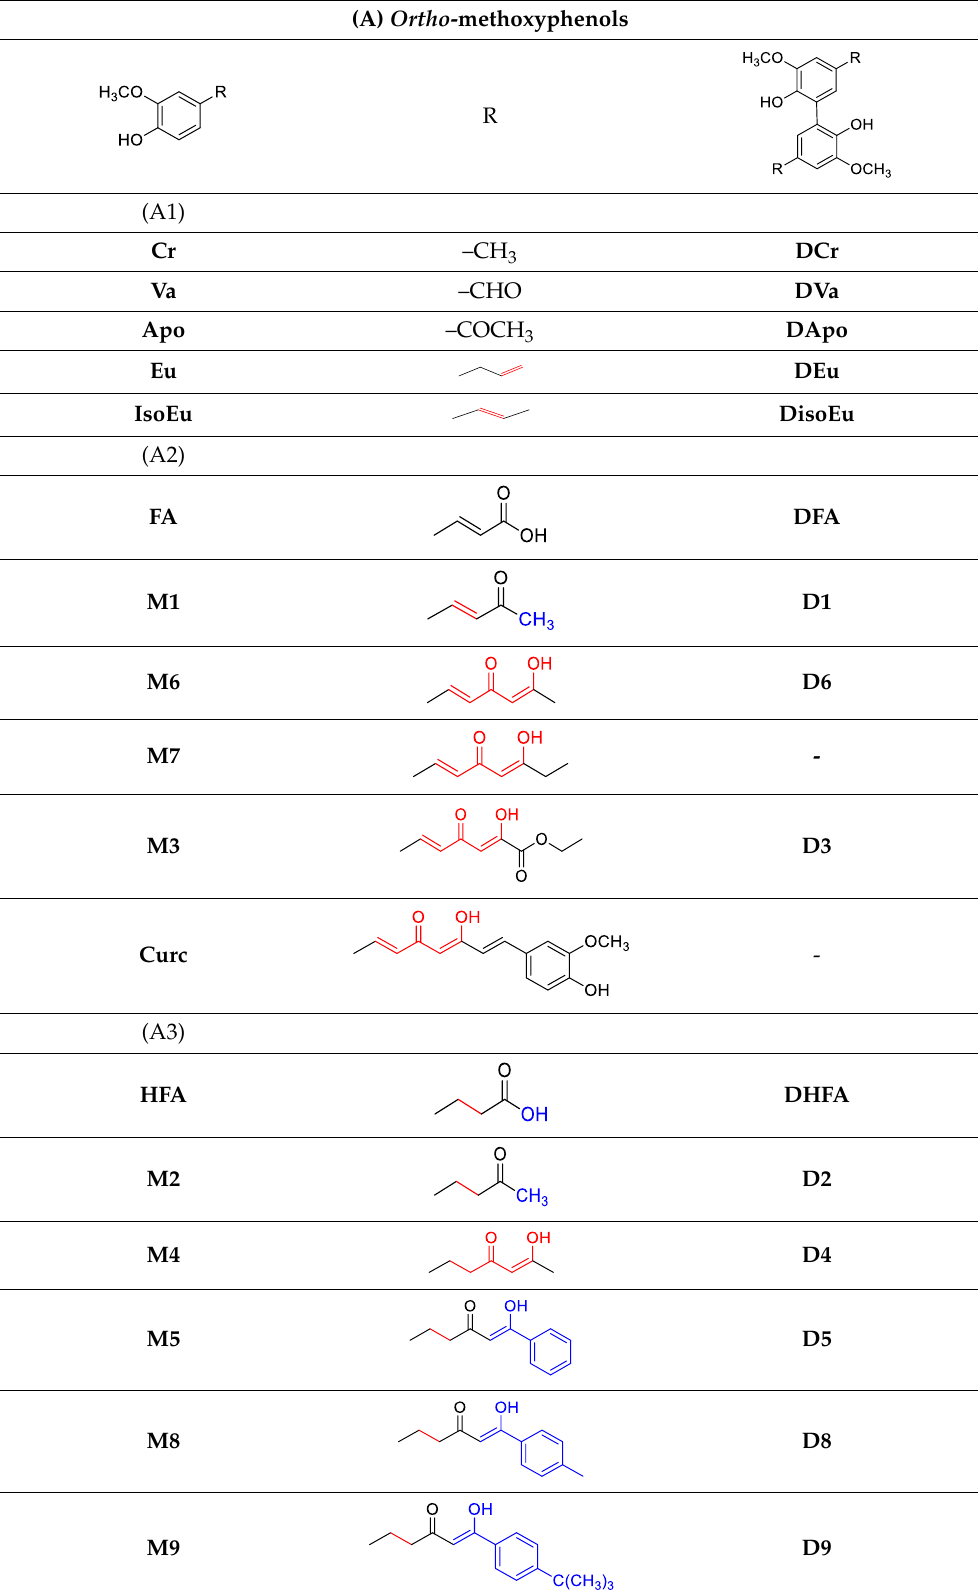
Table 1. Structures of all studied antioxidants.